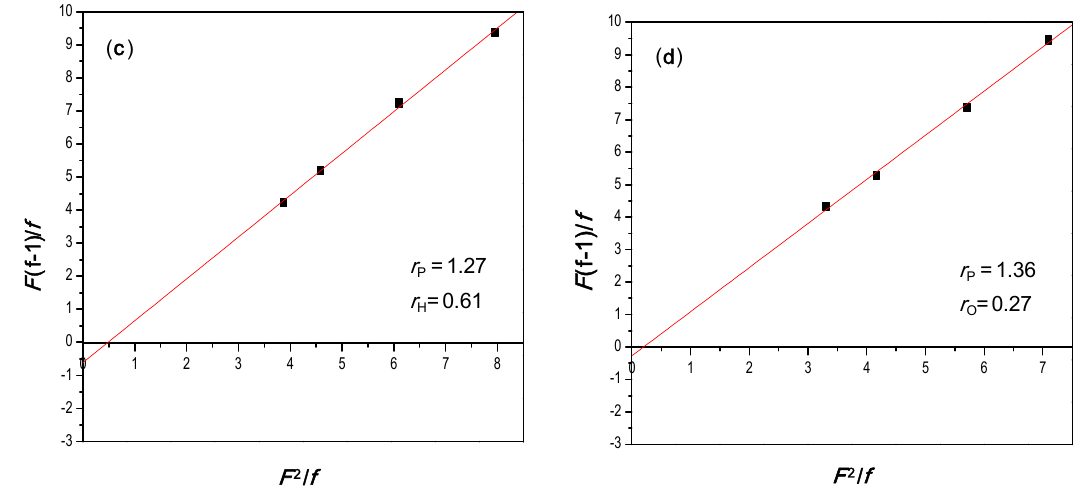
Figure 3. Fineman-Ross plots for copolymerization with 5-hexene-01-ol (AH) ( a ); 10-undecene-01-ol (AU) ( b ); 1-hexene ( c ); and 1-dodecene ( d ).